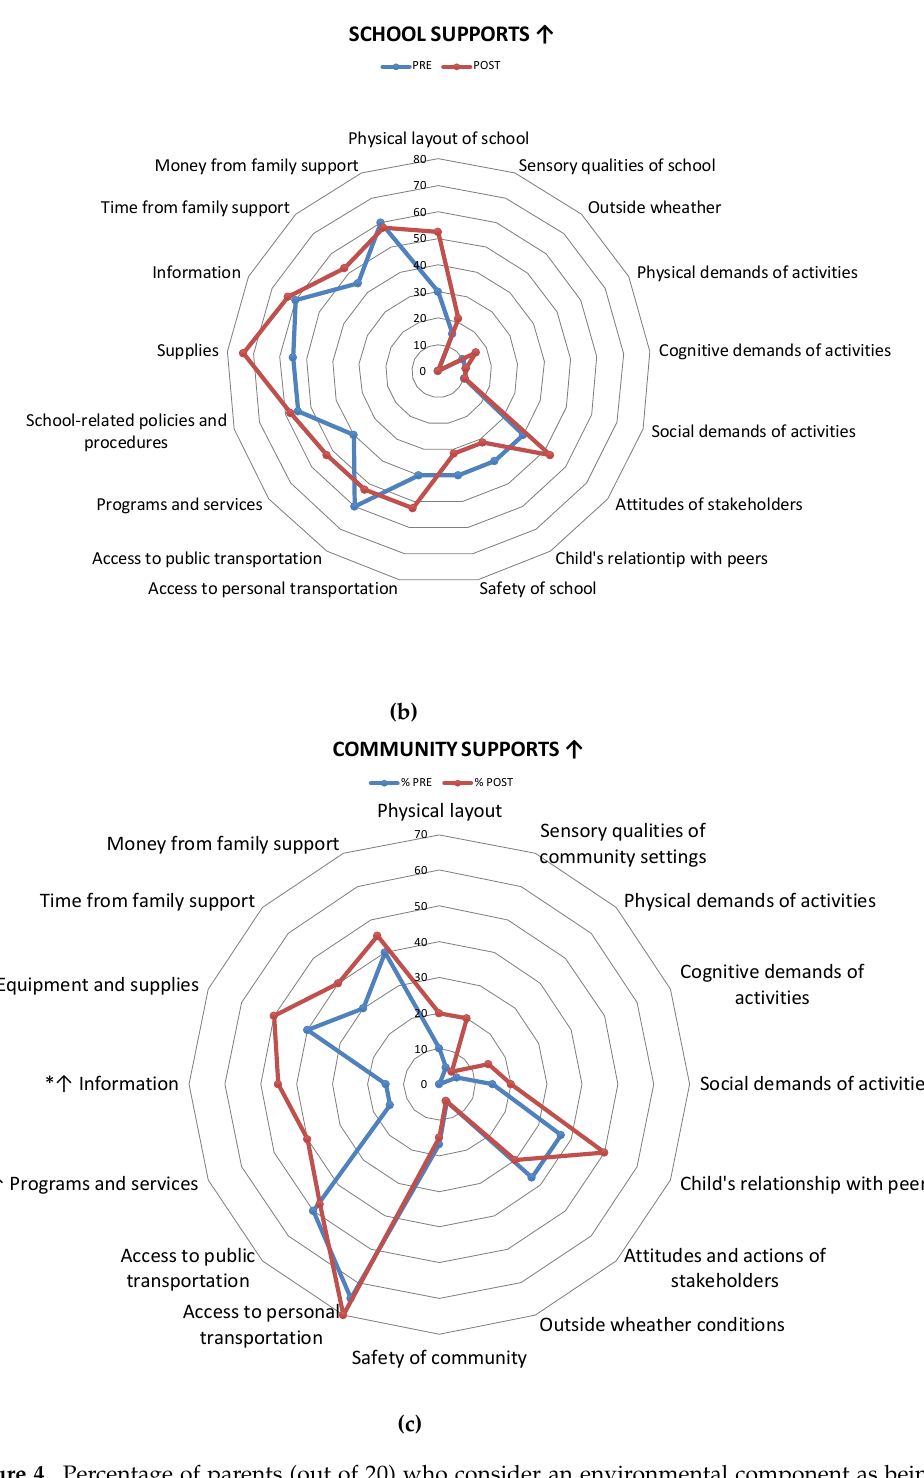
Figure 4. Percentage of parents (out of 20) who consider an environmental component as being a source of support in the home ( a ), school ( b ), and community ( c ) settings. ↑ = Increase in at least 20% of sample. * p < 0.05.